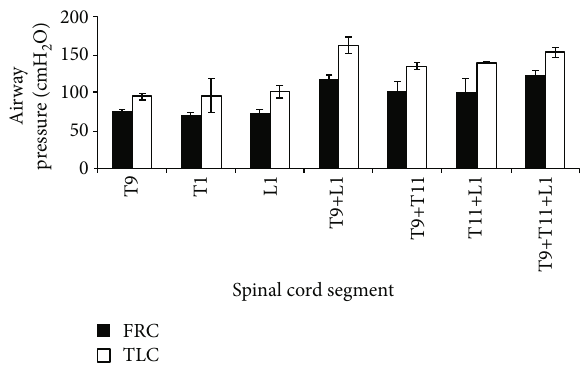
Figure 1: Airway pressure of di ff erent plans to activate cough.